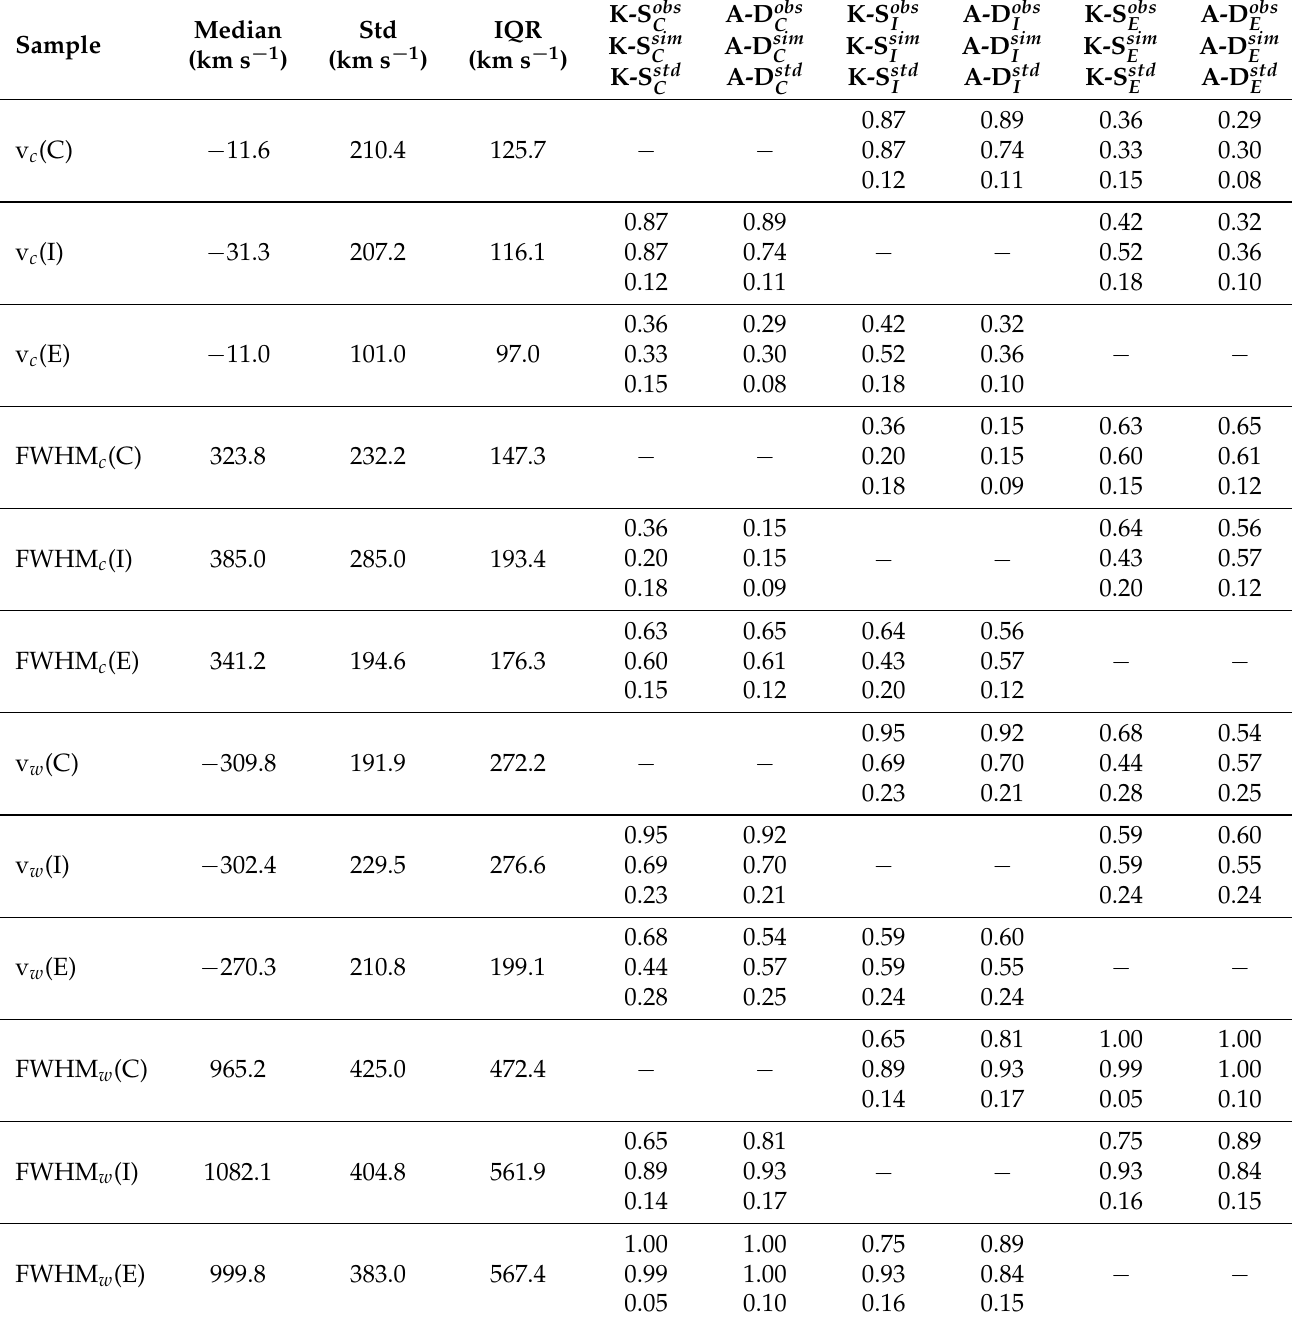
Table 7. Statistical tests results for the morphological samples. Columns: (1) Tested sample; (2) median velocity; (3) standard deviation of the velocity; (4) interquartile range; (5) p -value of the K-S tests against the corresponding C sample, observed in top row, simulated in middle row, and standard deviation of the simulated p -value in bottom row; (6) p -value of the A-D tests against the corresponding C sample, observed in top row, simulated in middle row, and standard deviation of the simulated p -value in bottom row; (7) K-S tests against the corresponding I sample, rows as before; (8) A-D tests against the corresponding I sample, rows as before; (9) K-S tests against the corresponding E sample, rows as before; (10) A-D tests against the corresponding E sample, rows as